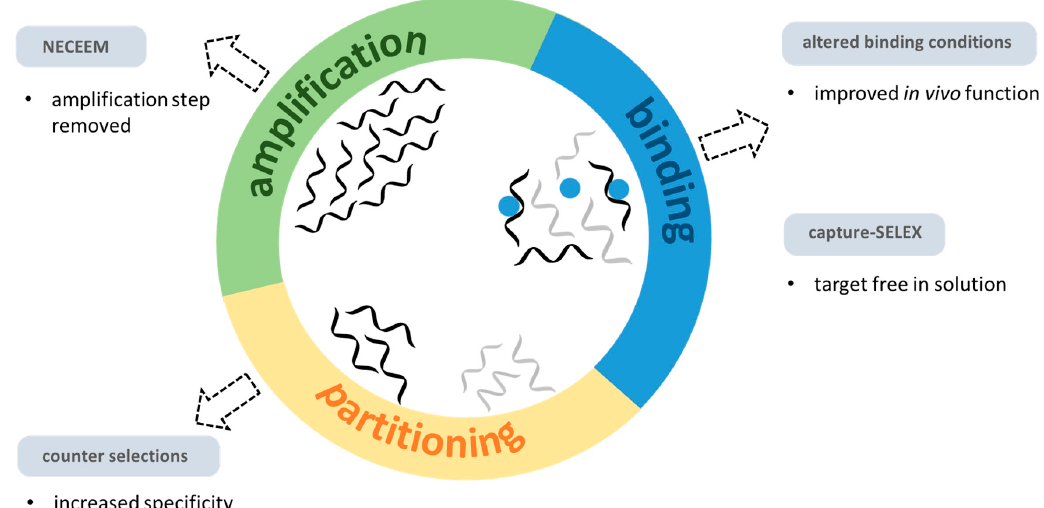
Figure 3. Conceptual representation of classic Systematic Evolution of Ligands by EXponential enrichment (SELEX) and important modifications. Classic SELEX consists of iterative rounds of binding, partitioning and PCR amplification. Single-stranded DNA or RNA libraries are incubated with the target-of-interest (blue circles). A partitioning step removes non-specific sequences (light grey strands). PCR amplification is then used to make multiple copies of the selected sequences (dark grey). Modifications to the classic SELEX process to isolate aptamers for DNA damage and repair targets include: the use of “capture-SELEX” for small molecules allowing them to be selected without immobilization; altered binding conditions to improve binding to strand breaks and improving activity in vivo; rigorous counter selection to ensure binding specificity; and the use of NECEEM for difficult protein targets.